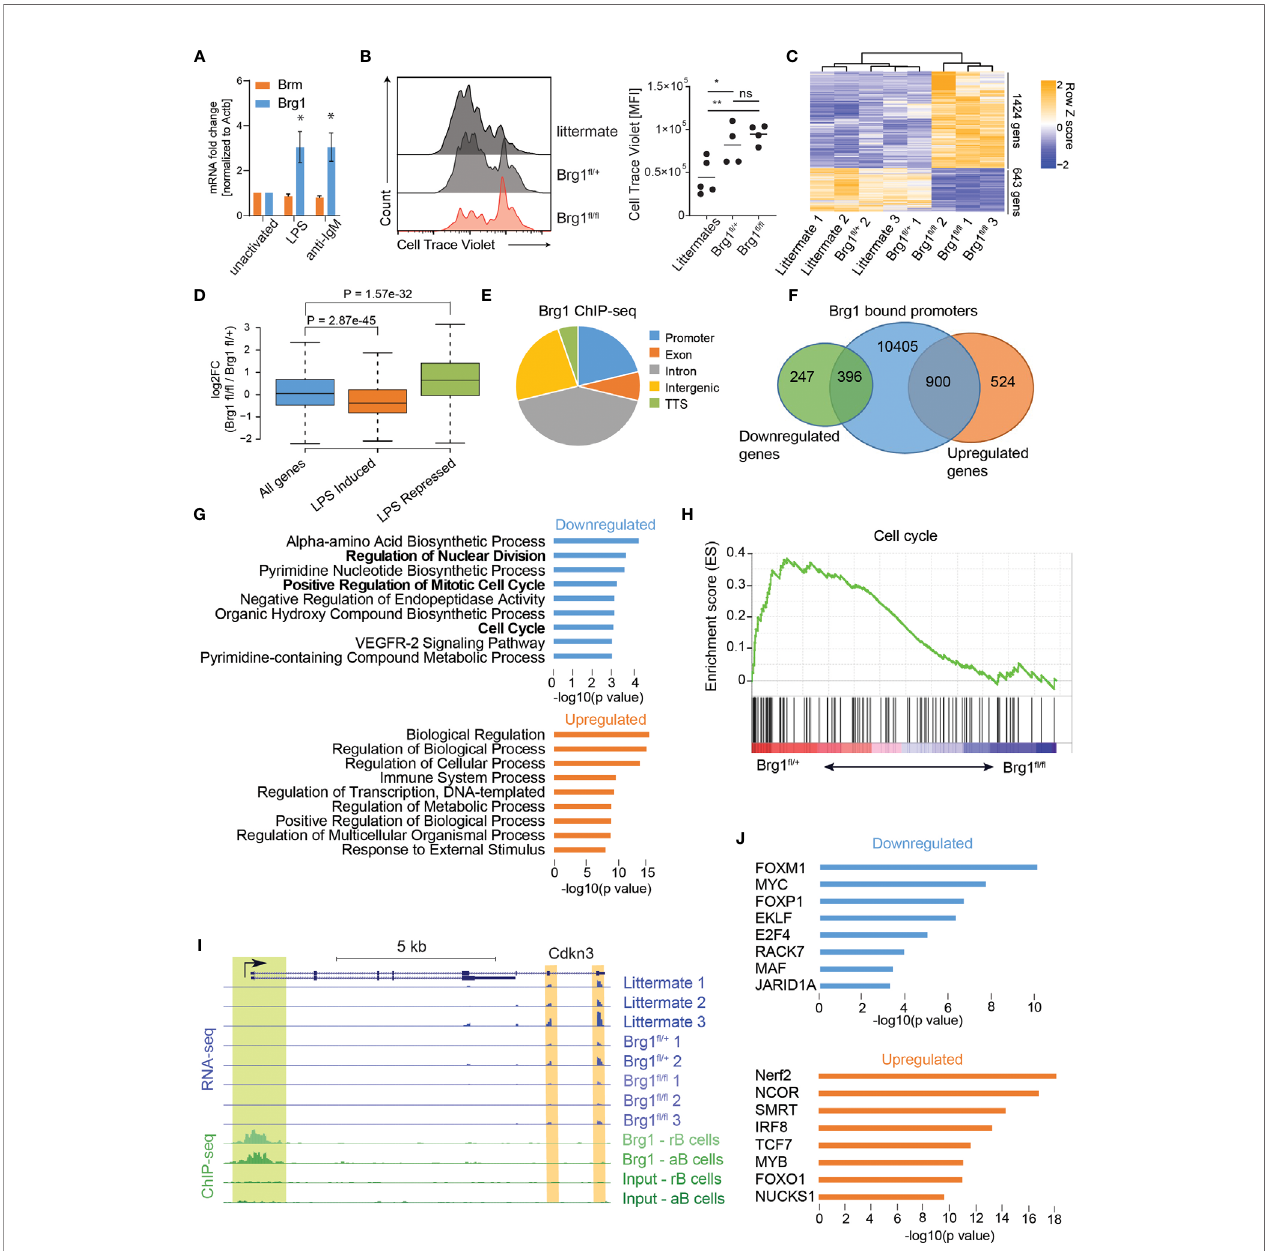
FIGURE 1 | Brg1 regulates the expression of cell cycle genes in activated B cells (A) qRT-PCR analysis of Smarca2 and Smarca4 mRNA levels of B cells following treatment with anti-IgM or LPS for 2 days, n = 3 mice, * p<0.05 in a one-sample t-test compared to unactivated cells. (B) Flow cytometric analysis of splenic B cell proliferation following 72 hours of LPS and IL-4 activation. MFI of CellTrace Violet cell tracker dye is shown and quanti fi ed. Each dot represents one mouse. Statistics were calculated with one-way ANOVA with post hoc Tukey ’ s multiple comparisons test. p<0.05 = *; p<0.01 = **; p>0.05 = ns (not signi fi cant). (C) Heat map representation of clustering analysis of differentially expressed genes. All genes with padj<0.05 and fold change of at least 2 are shown. (D) Boxplots indicating the median, quartiles, and 5th and 95th percentiles of changes in expression levels of CD23-Cre Brg1 fl / fl compared to Brg1 fl /+ B cells in genes induced or repressed following LPS activation compared to total genes. P value was calculated by a two-sided Wilcoxon rank sum test. (E) Distribution of 70,333 Brg1-binding sites across genomic regions in LPS activated B cells. TTS: transcription termination site. (F) Venn diagram showing overlap between 11,701 Brg1 bound promoters, 1,424 genes upregulated in Brg1 fl / fl compared to Brg1 fl /+ cells, and 643 genes downregulated in Brg1 fl / fl compared to Brg1 fl /+ cells. (G) GO terms which were enriched in genes whose promoters were bound by Brg1 and were down- or upregulated in CD23-Cre Brg1 fl / fl compared to Brg1 fl /+ B cells. (H) Gene set enrichment plot for cell cycle genes from the hallmark gene sets. (I) UCSC genome browser tracks showing the locus of Cdkn3 (padj < 0.05). Tracks show the expression levels, measured by RNA-seq, in activated B cells and ChIP-seq signal of Brg1 in resting and activated B cells, compared to input controls. Green highlight: binding of Brg1 in the promoter region. Orange highlights: 3 ’ end exons covered by RNA-seq. (J) Transcription factors enriched for binding the promoters of genes which were bound by Brg1 and were down- or upregulated in Brg1 fl / fl compared to Brg1 fl /+